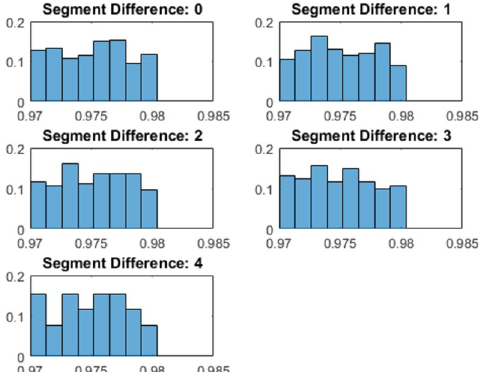
Fig 11. Histogram of physical similarity between pairs of shapes for each experimental condition in Experiment 3. Each histogram shows the distribution of similarities between shape pairs for each of the five experimental conditions. The x-axis gives the amount of physical contour difference between members of a pair, and the y-axis for each histogram gives the proportion of shape pairs with that amount of difference.